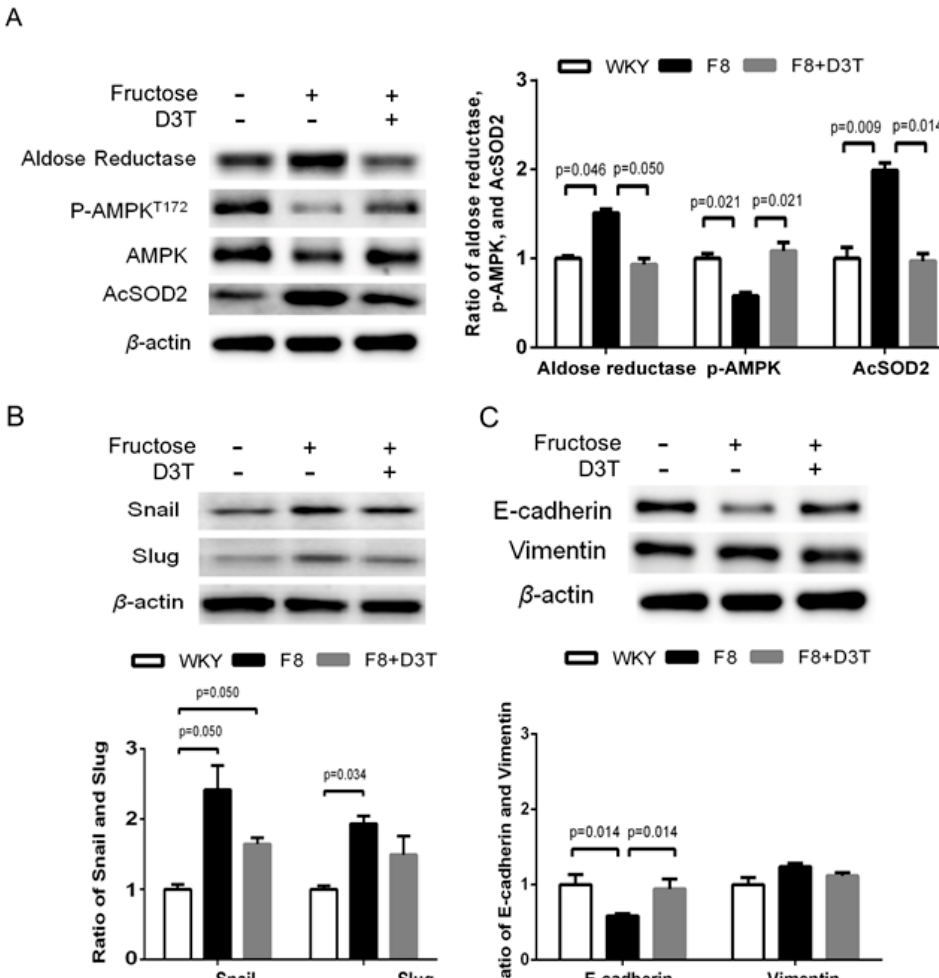
Figure 4. D3T reduces fructose − induced EMT progression in the lens of rats with fructose − induced type 2 DM. ( A ) Immunoblotting analysis depicting Aldose reductase, p-AMPK T172 and Ac-SOD2 expression in the fructose-induced type 2 DM lens with or without D3T administration. ( B ) Immunoblotting analysis showing Snail and Slug protein expressions in the frucTable 2. DM lens with or without D3T administration. ( C ) Protein expressions of E-cadherin and vimentin were also analyzed and quantified. All data represented as mean ± SEM ( n = 6 per group, independent experiments in each figure).